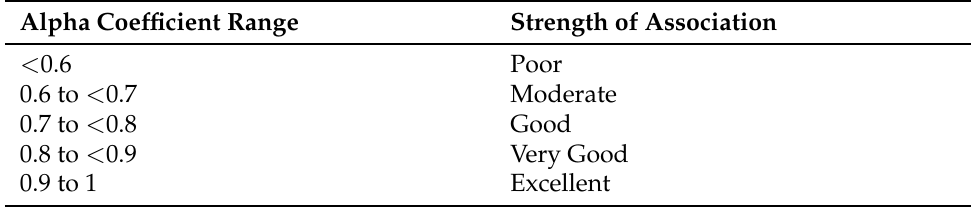
Table 3. Rule of Thumb on Cronbach’s Alpha [56,57].